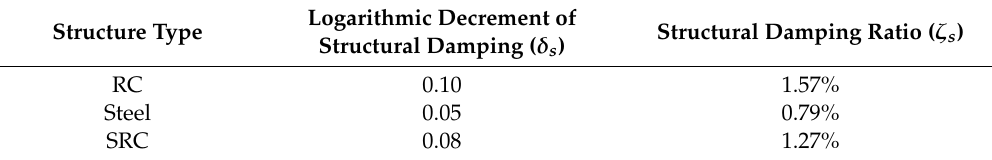
Table 2. Logarithmic decrement of structural damping in the fundamental mode in Eurocode 1.